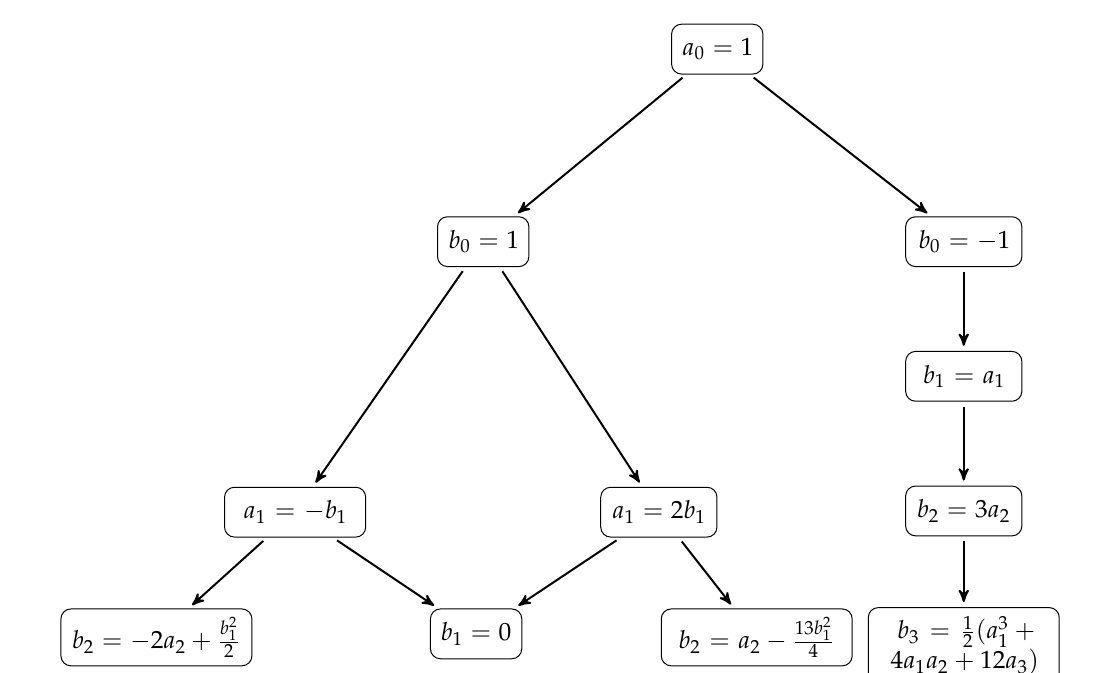
Figure 1. Bifurcation of possible spherically symmetric asymptotically flat solutions of f ( T ) gravity. The constants a i and b i are defined as in Equations (25) and